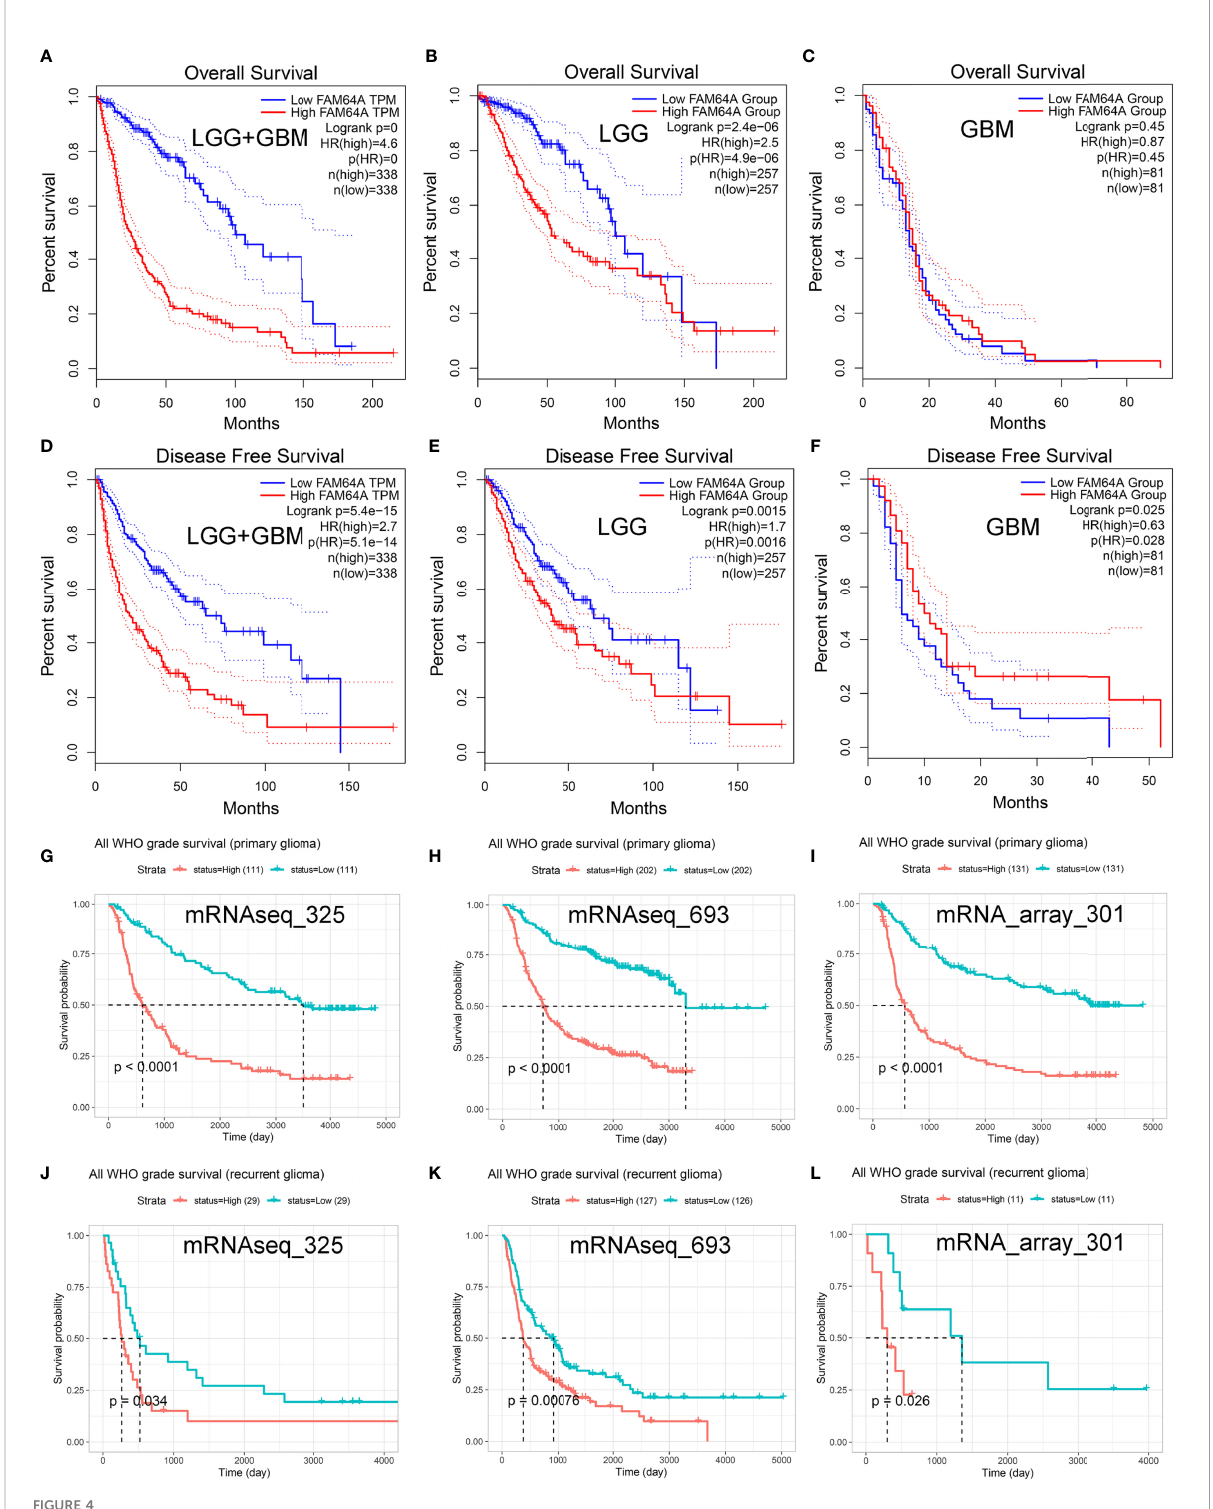
FIGURE 4 Predictive value of PIMREG (FAM64A) in glioma prognosis. Correlation of PIMREG expression with OS of glioma (A) , LGG (B) , and GBM (C) . Correlation of PIMREG with the DFS of glioma (D) , LGG (E) and GBM (F) . Correlation between PIMREG and survival probability of all WHO-grade primary (G – I) and recurrent (J – L) glioma in CGGA